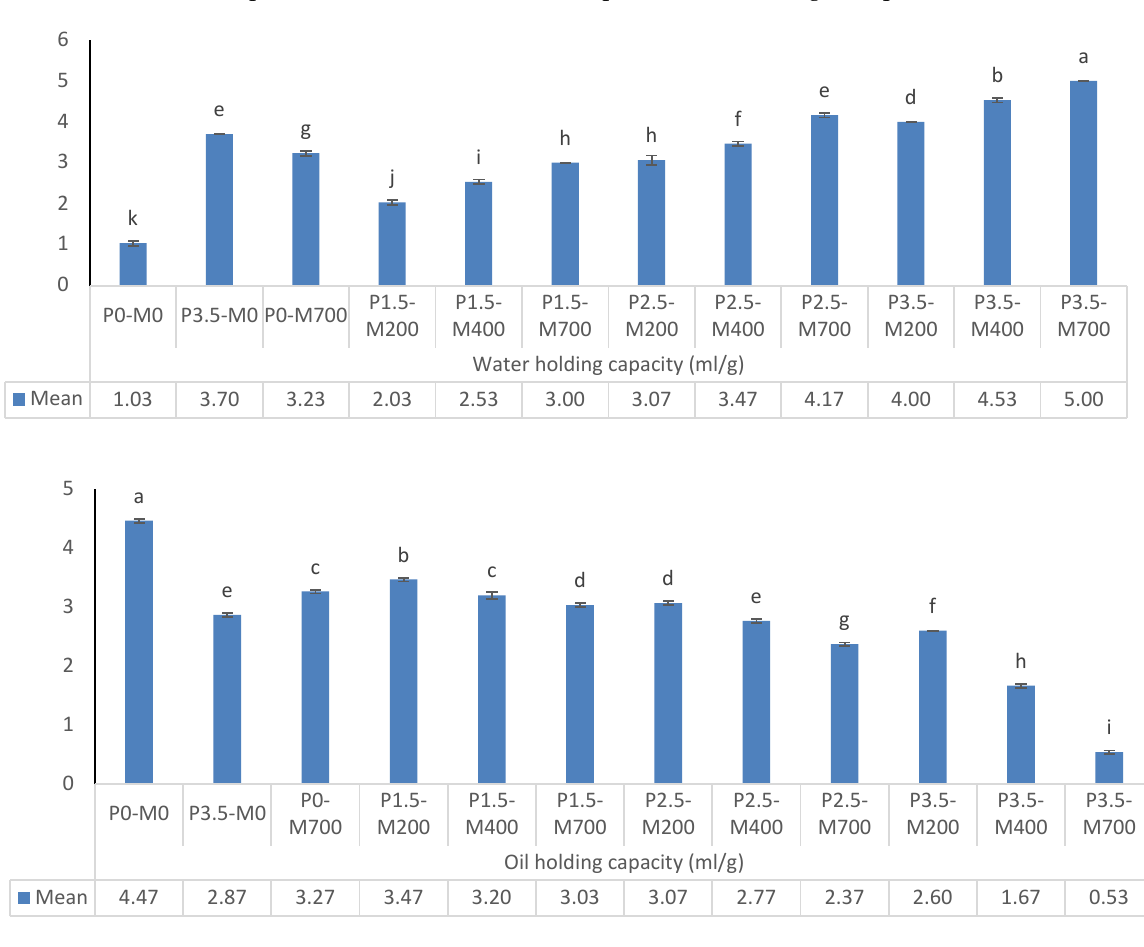
Figure 4. The effect of phosphorylation (%) and microwave power (W) on water-holding capacity and oil holding capacity of egg white powder. Means ( n = 3) with different letters in each column indicate significant difference ( p < 0.05).